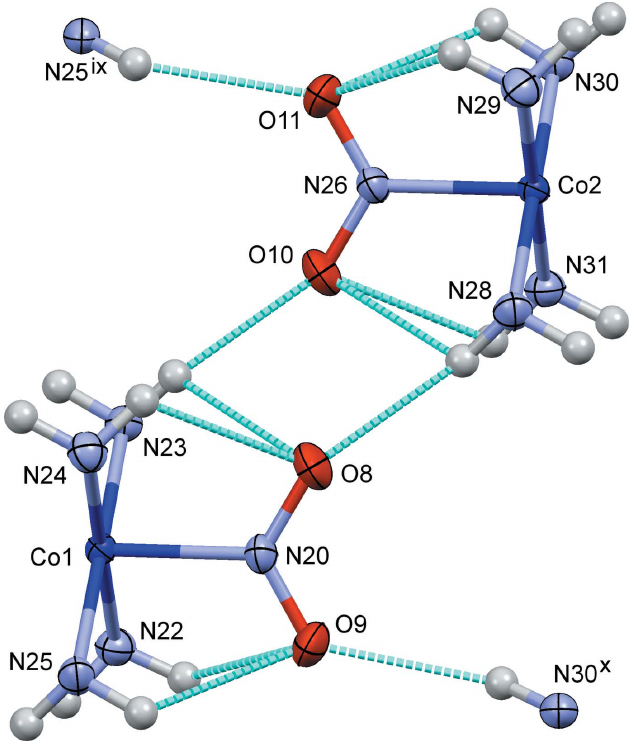
Figure 9 The steric circumstances of the nitro groups in (III). Dashed lines in blue show the O(nitro) (cid:2)(cid:2)(cid:2) H short contacts shorter than 2.5 A˚ . Only parts of the diamine ligands are shown for clarity. Symmetry codes: (ix) (cid:3) x + 1 y + 1 , (cid:3) z + 1 ; (x) (cid:3) x + 3 , y (cid:3) 1 , (cid:3) z + 1 . 2 2 2 2 2